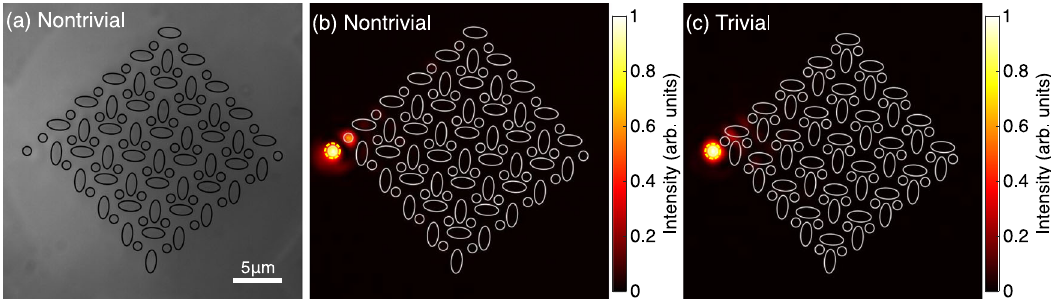
indicated with yellow dashed circles. The intensity pro fi les are normalized to their respective maximum value to increase visibility.In a and b , c , blackand white lines are overlapped to indicate the positions of the waveguides, respectively. An ana- logous experimental measurement of the corner mode localized at the p -orbital cornerispresentedinSupplementaryMaterialsectionIV."Observationofp-orbital corner